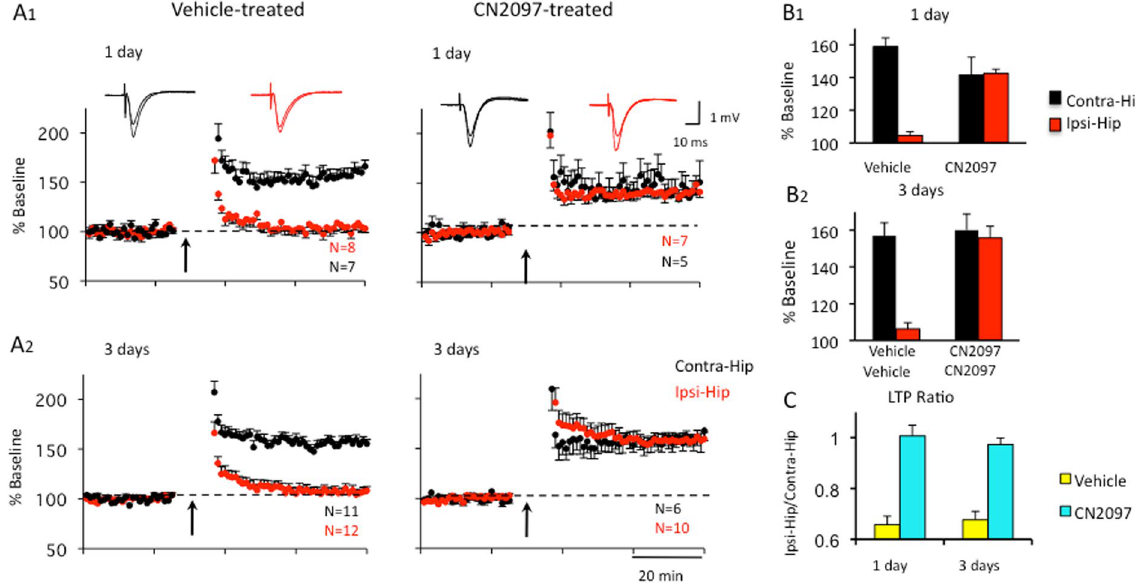
Figure 3. CN2097 attenuates TBI-induced hippocampal LTP deficits. Rats were injected i.p. with CN2097 (10 mg/kg) or vehicle (0.9% NaCl) at 1 and 2 h post-TBI. Extracellular field potentials (fEPSP) to Schaffer Collateral stimulation were recorded in CA1 at 1 and 3 days following treatment. ( A ) LTP was recorded in both the contralateral (Contra-Hip) and ipsilateral (Ipsi-Hip) hippocampal slices at 1 d ( A1 ) and 3 d ( A2 ) following vehicle (left) and CN2097 treatment (right). Left: Following TBI, LTP (2 × 100 Hz for 1 s, 20 s apart; arrows) was impaired in the ipsilateral (Ipsi-Hip, red), but not the contralateral hippocampus (Contra-Hip, black). Right: CN2097 restored LTP to control levels. Field EPSP slopes in the CA1 region are plotted as a percentage of baseline. Insets: Examples of fEPSP traces representing averages of 20 responses at baseline and LTP (Contra, black; Ipsi, red). ( B ) Group data of LTP in vehicle- and CN2097-injected rats at 1 d ( B1 ) and 3 d ( B2 ) following TBI. ( B1 ) At 1 d after TBI and vehicle treatment, LTP was significantly impaired in the ipsilateral compared to contralateral hippocampus. After CN2097 treatment, LTP was restored in the ipsilateral hippocampus to a level that was not significantly different from that observed in the contralateral hippocampus. ( B2 ) At 3 d following TBI, synaptic plasticity was similarly restored. In CN2097-treated rats, LTP in the ipsilateral hippocampus was not different from that observed in the contralateral hippocampus, while vehicle treatment resulted in a significant interhemisphere difference ( C ). Interhemisphere ratio (Ipsi/Contra) of LTP indicates highly impaired LTP in the ipsilateral hemisphere of vehicle-treated rats (yellow) when compared to CN2097-treated rats (blue) at 1 d as well as at 3 d post-TBI. Data represent mean ±